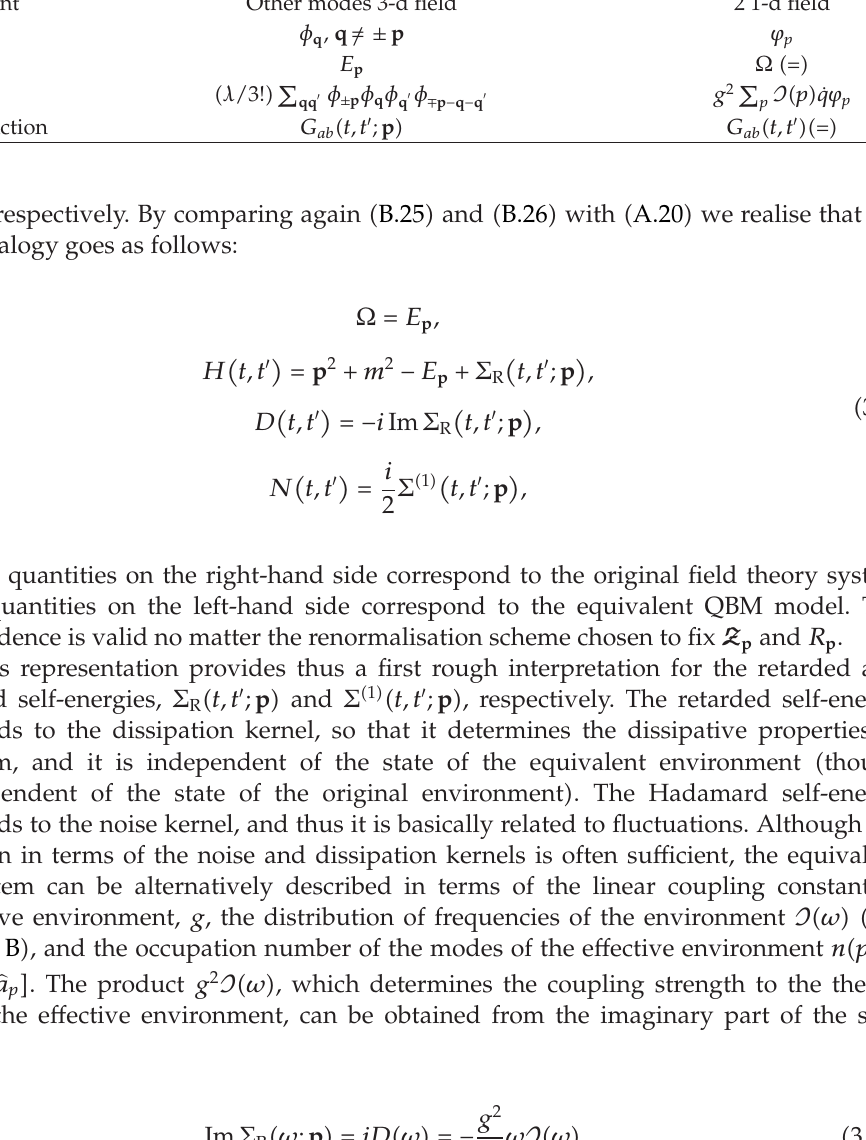
Table 1: Detail of the equivalent linear QBM system for a λφ 4 quantum field theory. The λφ 4 model has been chosen for concreteness, but the correspondence would be analogous for any other field theory model. The symbol (cid:7)(cid:6)(cid:8) indicates that the original and equivalent quantities are indeed identical despite the name change. Original system Equivalent linear QBM System Two field modes Two identical oscillators System d.o.f. Environment Other modes 3-d